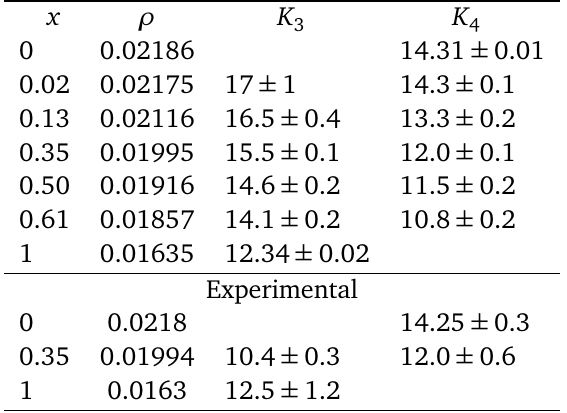
, and 4 He, K at each 3 4